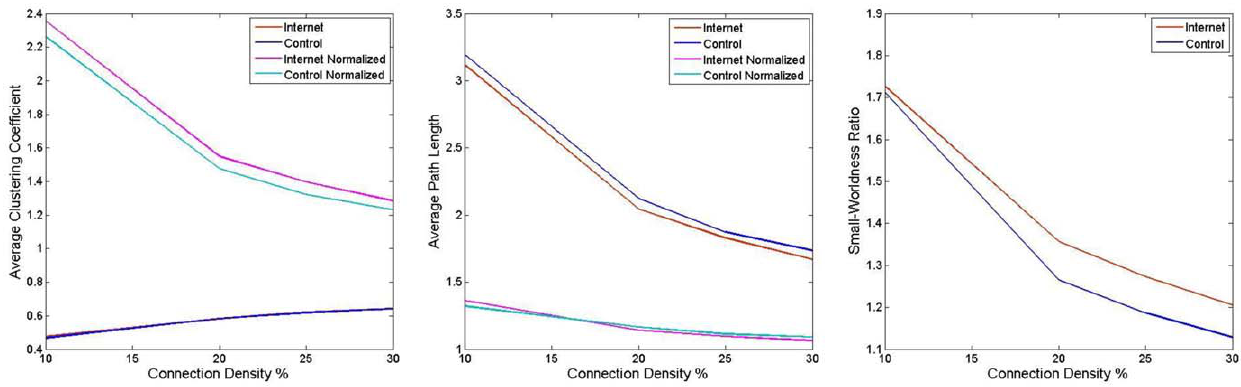
Figure 3. Small-world parameters of brain functional connectivity in adolescents with internet addiction.